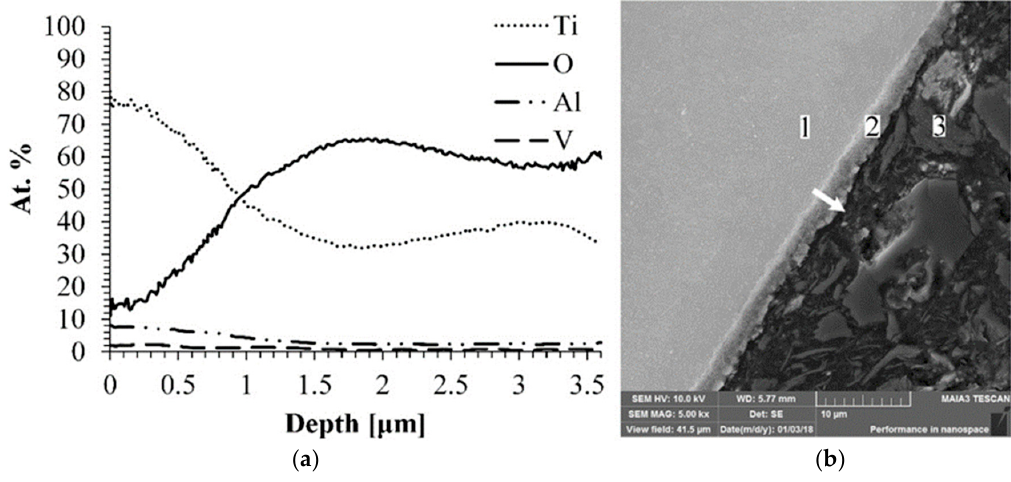
Figure 5. EDS line scan of the alloy Ti-6Al-4V after MAO treatment ( a ) and its cross section microphotograph obtained by SEM ( b ). Arrow indicates the direction of the EDS line scan analysis. Points in images attributed to: 1—base alloy; 2—oxide layer; 3—resin.